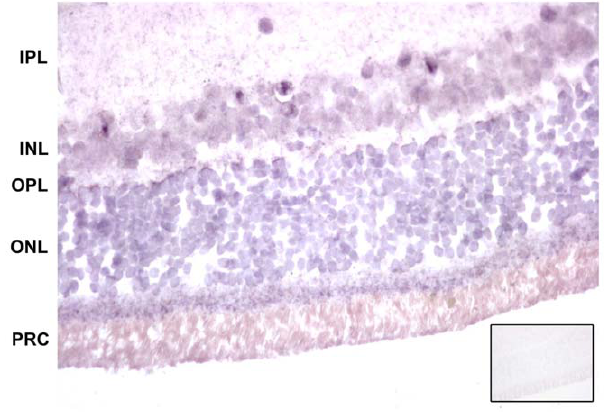
Figure 5. In situ hybridization in a paraffin section of a LEW/ Ztm- ci2 rat indicates the presence of Myo15 mRNA in the retina. The insert demonstrates the same retina with the sense-control. ( 6 80) IPL=Inner Plexiform Layer, INL=Inner Nuclear Layer, OPL=Outer Plexiform Layer, ONL=Outer Nuclear Layer, PRC=Inner and Outer Segments of Photoreceptor Cells.